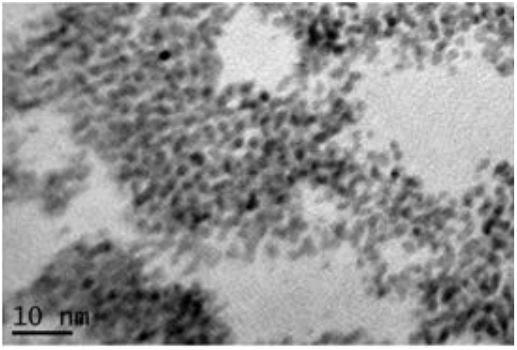
Figure 3. TEM image of colloidal iridium nanoparticles (Reprinted/adapted with permission from Ref. [77]).